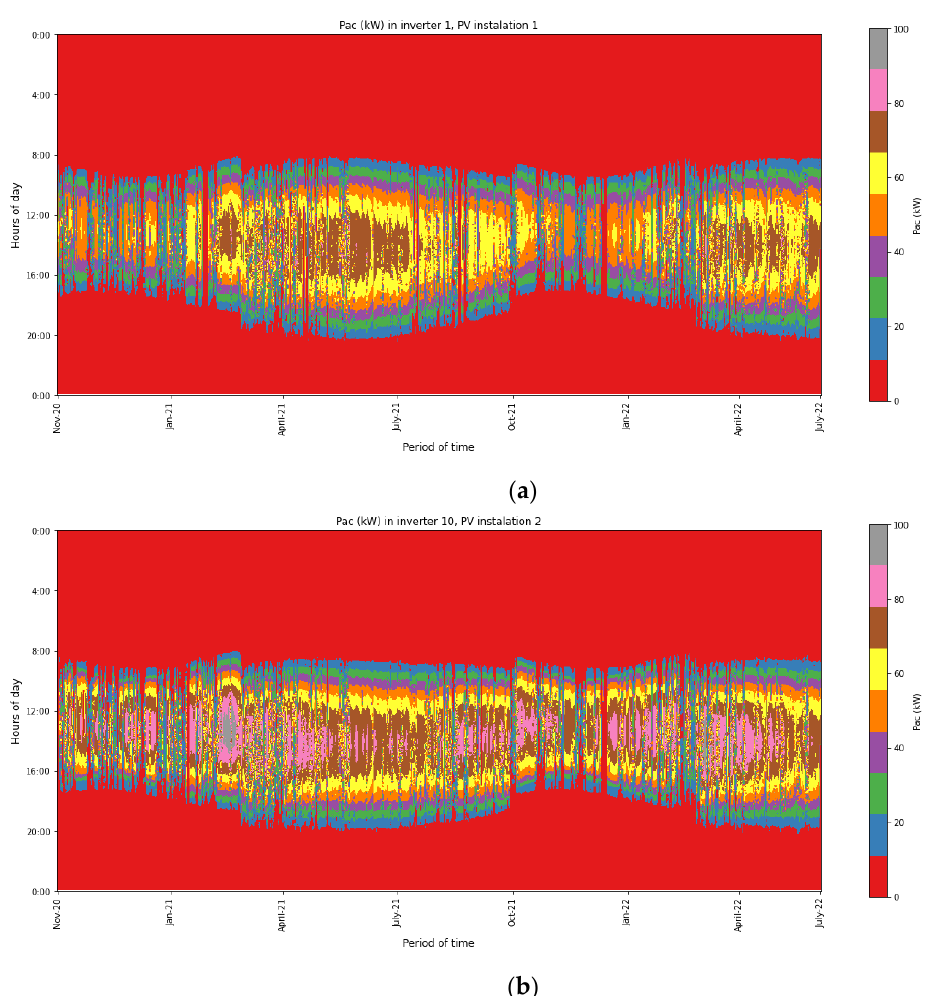
Figure 12. Instantaneous P ac values recorded at the output of inverters 1 of plant 1 ( a ) and 10 of plant 2 ( b ), in the period from 1 November 2021 to 4 July 2022.